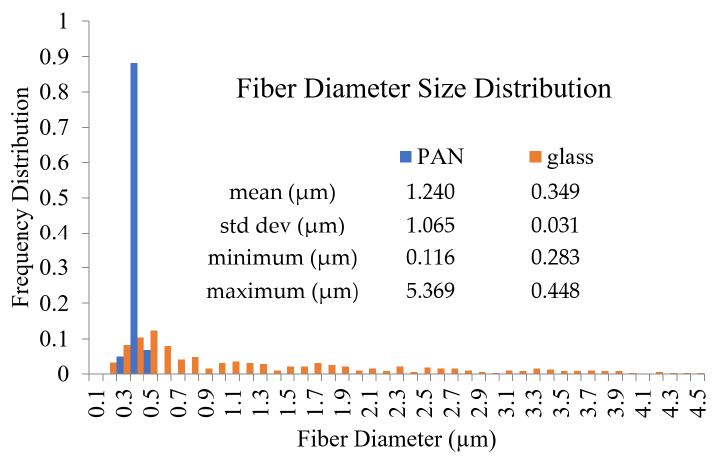
Figure 15. Fiber diameter size distribution of glass HEPA filter paper and polyacrylonitrile media.